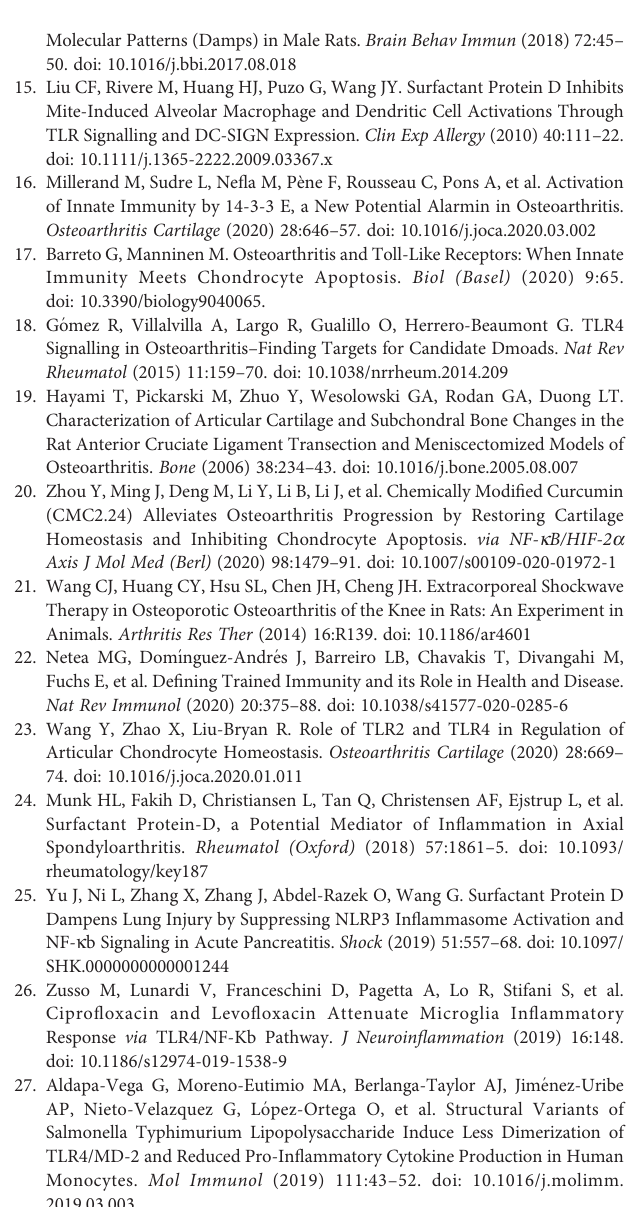
Supplementary Figure 1 | DEGs were annotated to GO database to detect the gene function. (A – D) GO analysis showed that the biological processes such as regulation of ‘ extracellular space ’ , ‘ protein binding ’ and ‘ chemokine activity ’ were associated with SP-D in chondrocytes. Supplementary Figure 2 | RAAV-mediated SP-D gene was transferred into the rat knee joints. (A) SD rats received an intra-articular injection of rAAV encoding SP- D-speci fi c shRNA for SP-D or GFP into the knee for 10 consecutive days. SP-D expression in synovium and cartilage was assessed via western blotting. (B) The ratios of SP-D in synovium and cartilage were analyzed. Data were expressed as mean ± SEM (n = 3). *** P < 0.001 versus the rAAV-GFP group. Supplementary Figure 3 | Suppression of TLR4 mediated PI3K signaling by SP- Dtreatment in OA synovium. (A) Immuno fl uorescence with an antibody to p-PI3K in